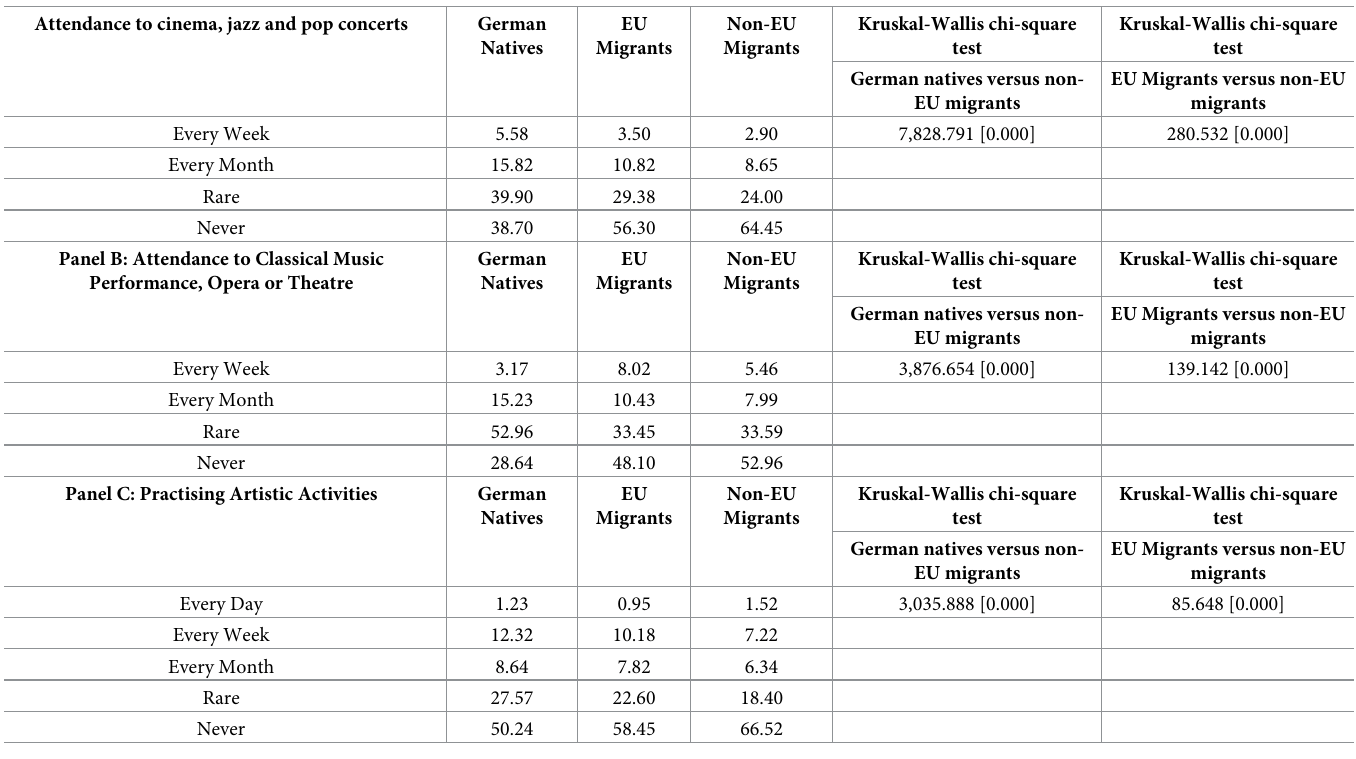
Table 2. Frequency of